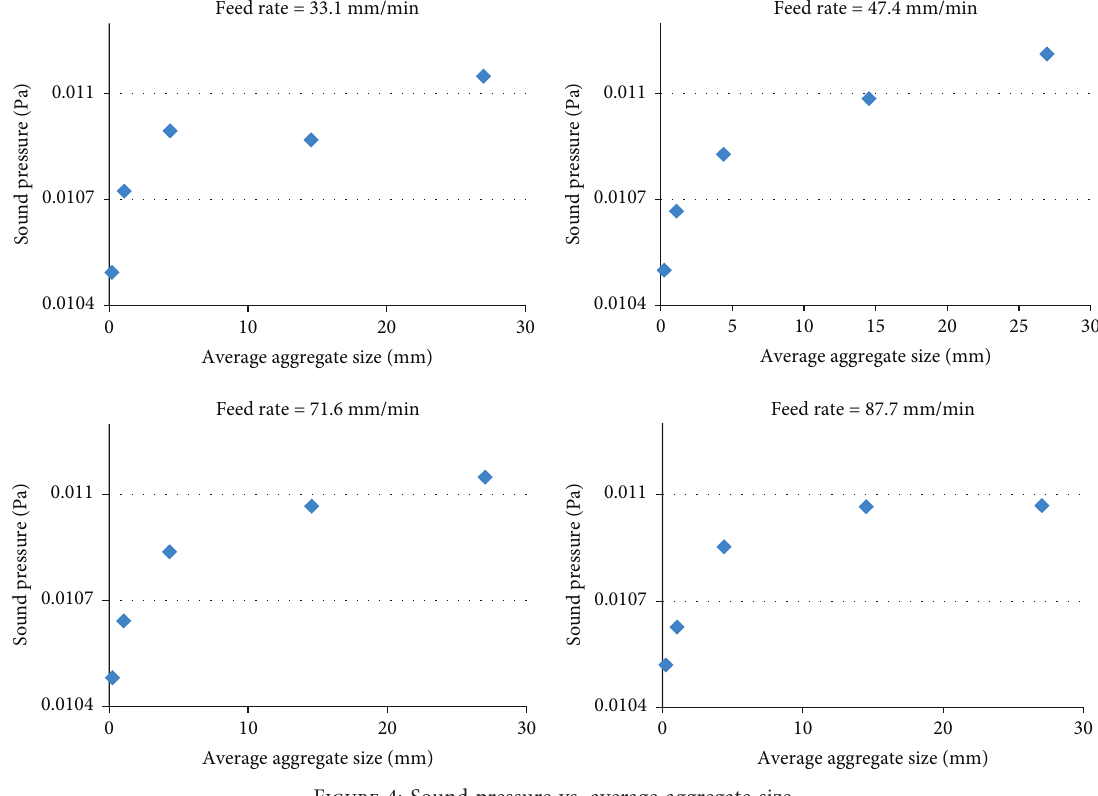
Figure 4: Sound pressure vs. average aggregate size.